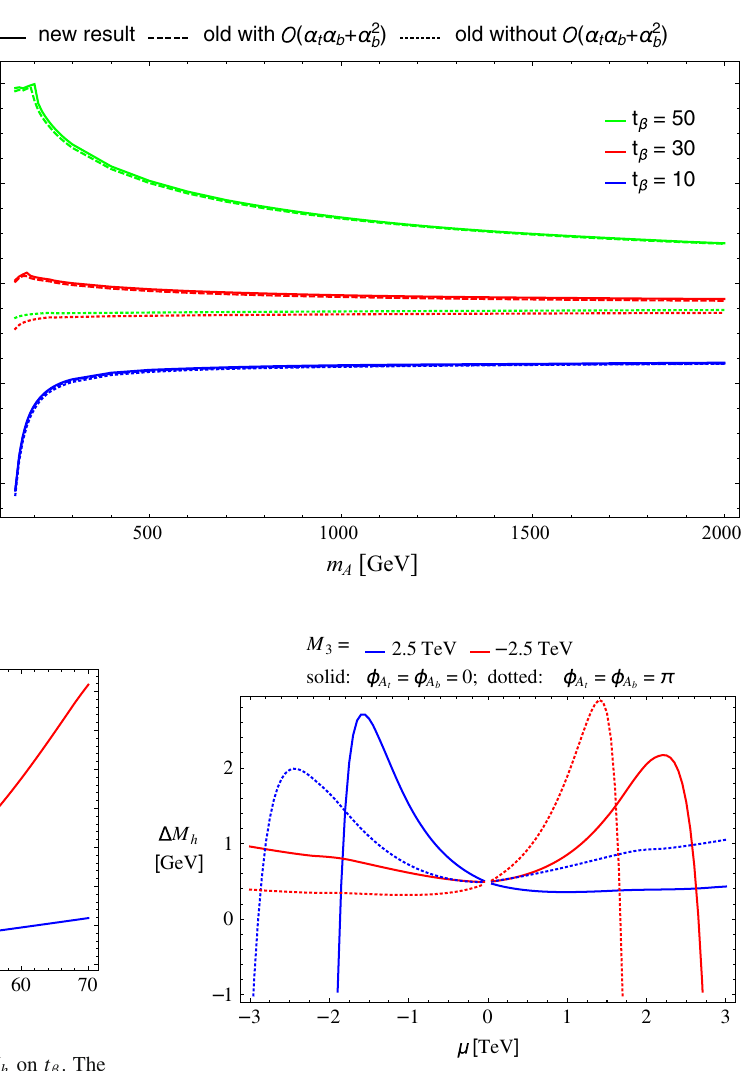
Fig. 2 Comparison of the lightest Higgs-boson mass M h as predicted with our new two-loop corrections (solid), the version of FeynHiggs for the MSSM with real parameters, (cid:2) (cid:3) α + α 2 α i.e. including O t b b corrections (dashed), and the version of FeynHiggs for the MSSM with complex parameters, i.e. without (cid:2) (cid:3) α + α 2 α O corrections t b b